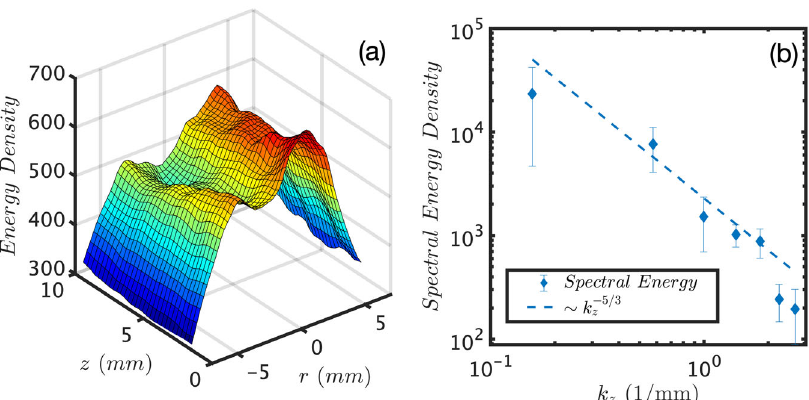
Fig. 3 Energy density and spectral energy density of fl ow. a Energy density E ( r , z ) for a jet- fl ow of Re ≈ 78,000. b Decay of ^ E ð k r ¼ 0 ; k z Þ as a function of k z . Each blue diamond represents the mean of ^ E ð k r ¼ 0 ; k z Þ at four successive points and error bars, the associated standard deviations. Dashed line